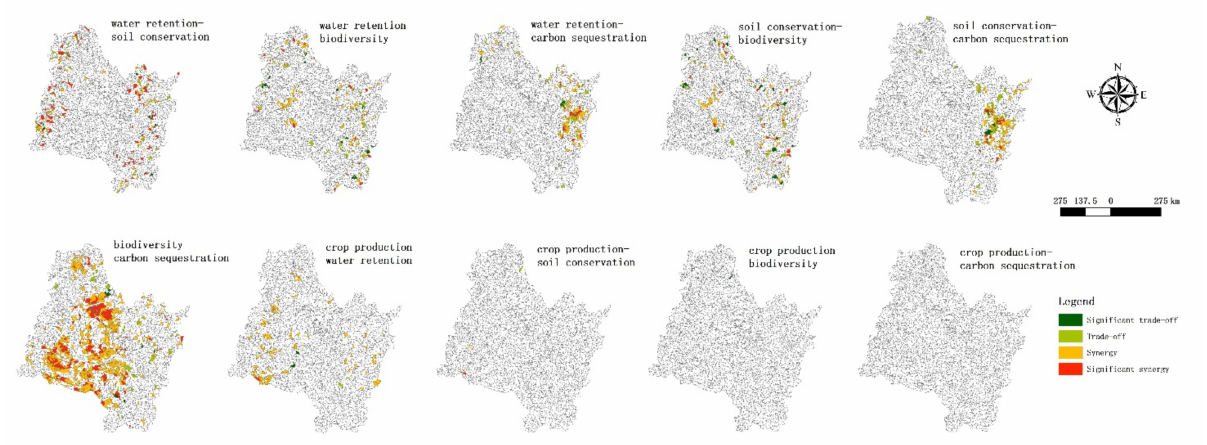
Figure 20. Time-scale ecosystem service